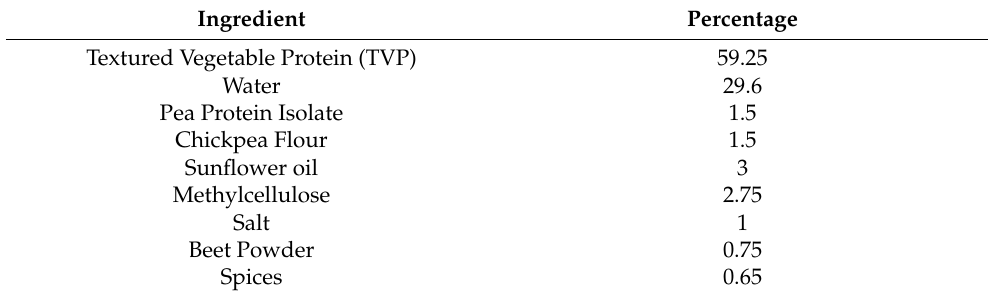
Table 5. Patty formulation for textural analysis. TVP refers to the extruded treatments as per Table